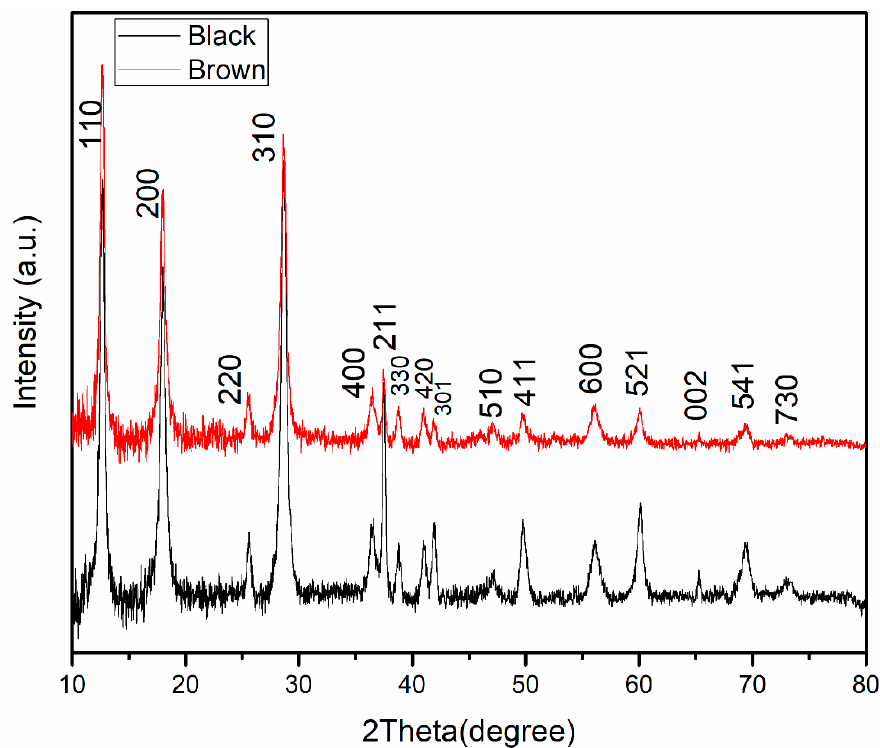
Figure 1. X-ray powder diffraction of the black and brown α -MnO 2 synthesized using the hydrothermal method.